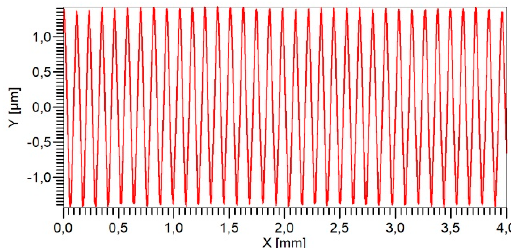
Figure 35. Micro Profiler measurement on a sinusoidal roughness artefact.